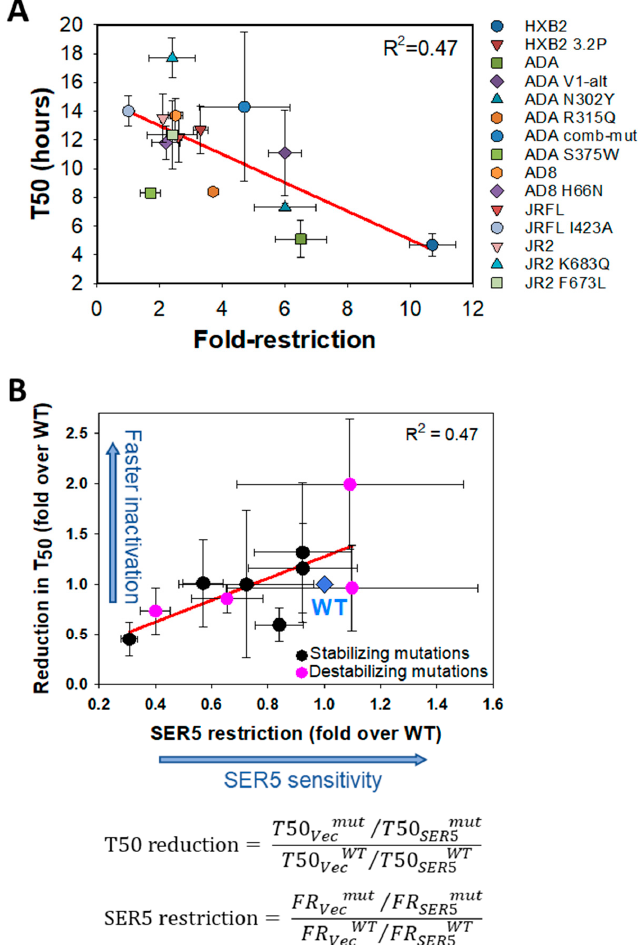
Figure 2. Correlation between the rates of inactivation and fold restriction by SER5 for wild-type and mutant HIV-1 Env glycoproteins. The experiments were performed as depicted in Figure 1A. ( A ) Scatter plot showing correlation between T 50 and SER5 fold restriction for five wild-type (WT) Envs and 10 Env mutants. A linear regression plot is shown by the red line. The data are means and